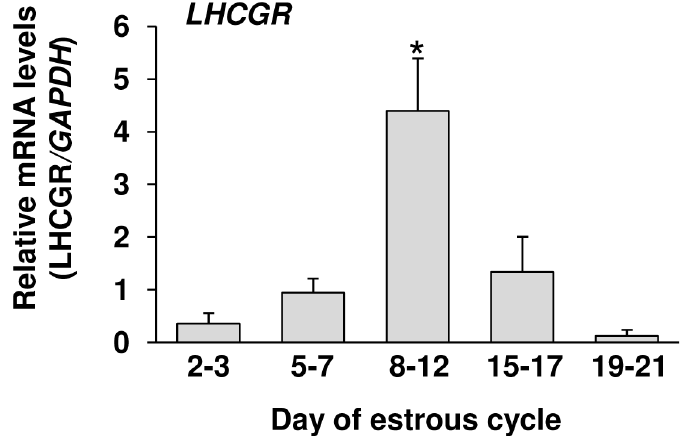
Figure 7. LHCGR expression in the bovine CL. Relative levels of LHCGR mRNA in bovine CL throughout the estrous cycle (n=4). Asterisks indicate significant differences (P<0.05), as determined by ANOVA followed by Fisher’s PLSD as a multiple comparison test.